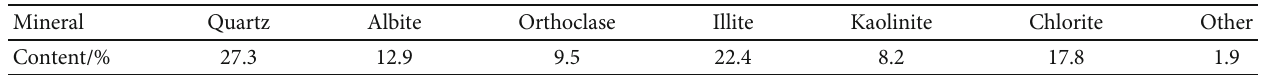
Figure 2: Rock sampling and sample preparation. (a) Sampling location, (b) siltstone at 12306 workface in Shangwan coal mine, and (c) processed samples of rock. Table 1: Mineral content of rock